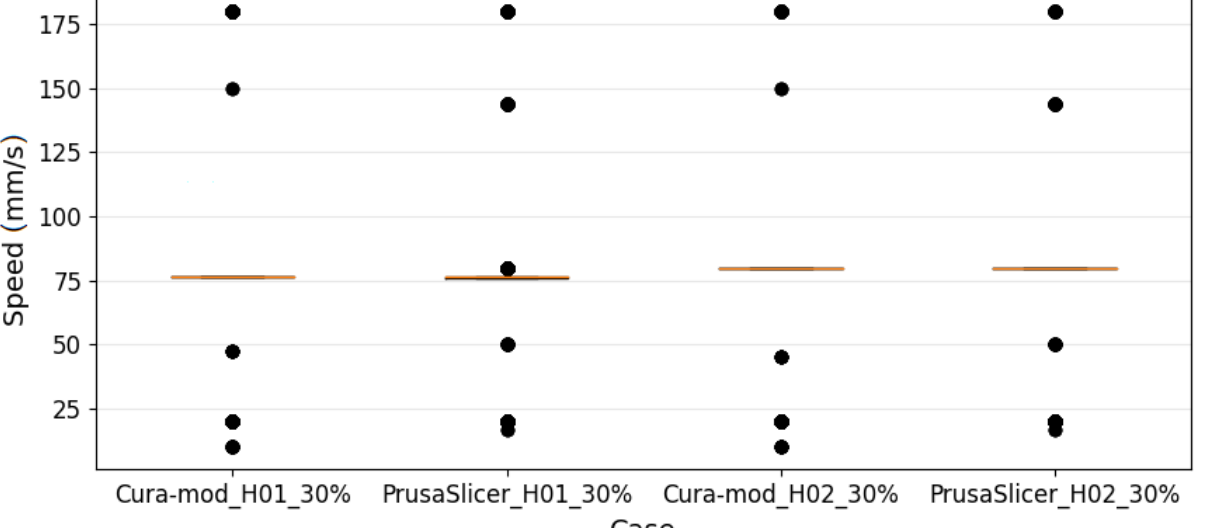
Figure 10. Speed of the print